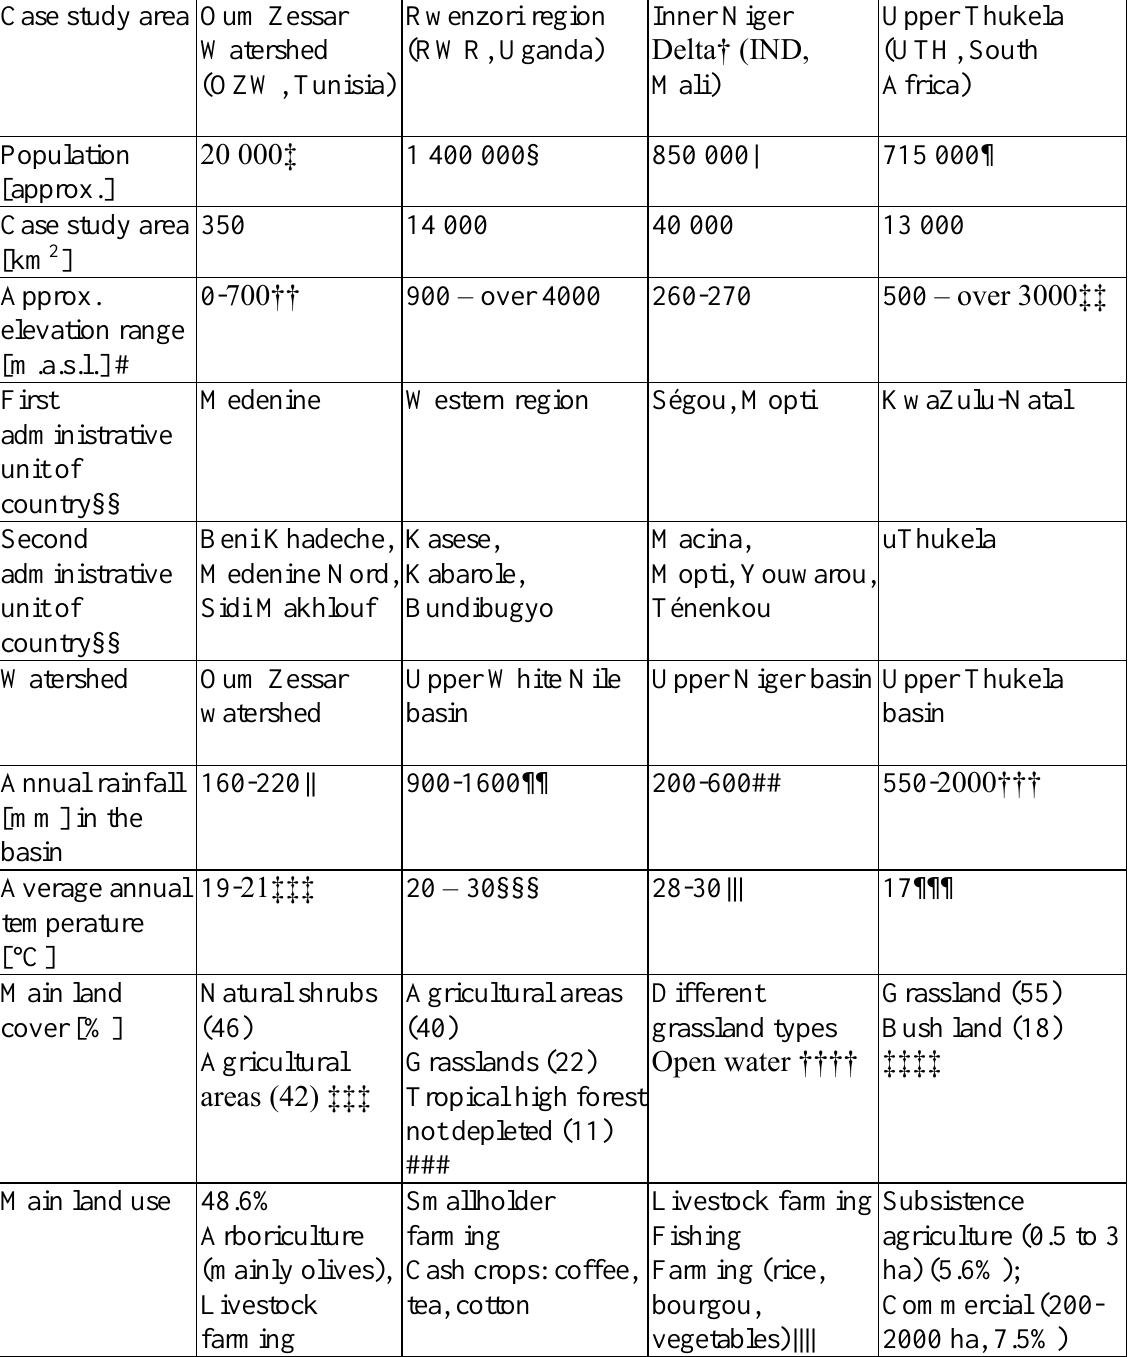
Table A1.1: Main characteristics of case study